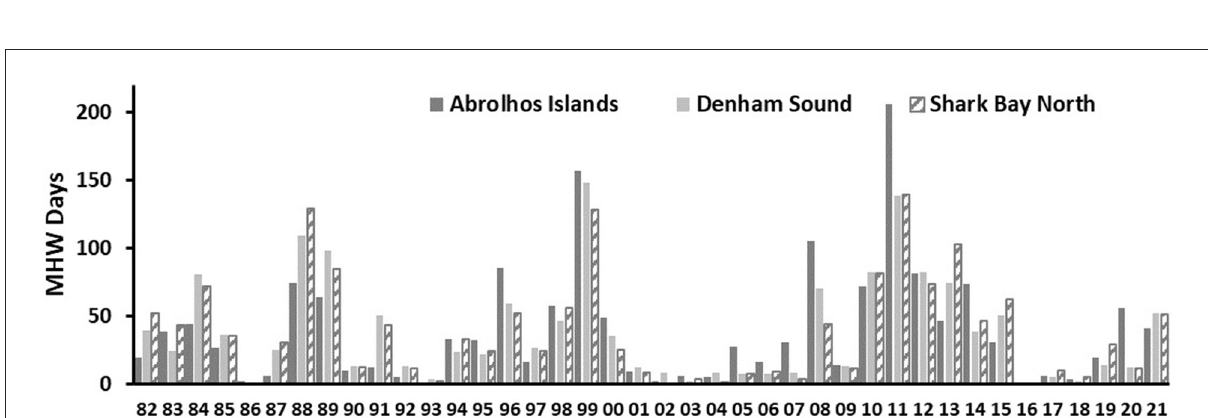
FIGURE4 Annual number of MHW days between 1982 and 2021 at the Abrolhos Islands, Denham Sound and Shark Bay North